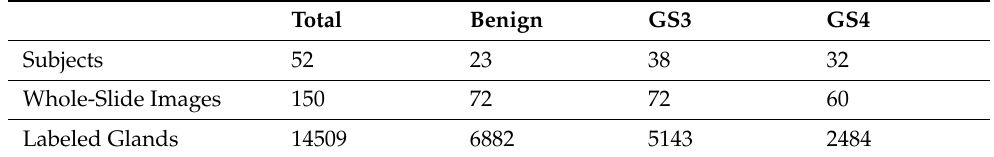
Table 1. University of Miami/Moffitt Cancer Center